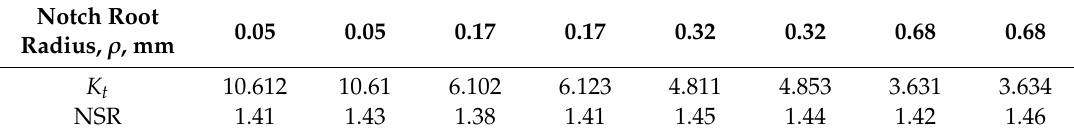
Table 3. Stress concentration factor and notch strength ratio of stress-relieved material. Notch Root Radius, ρ ,